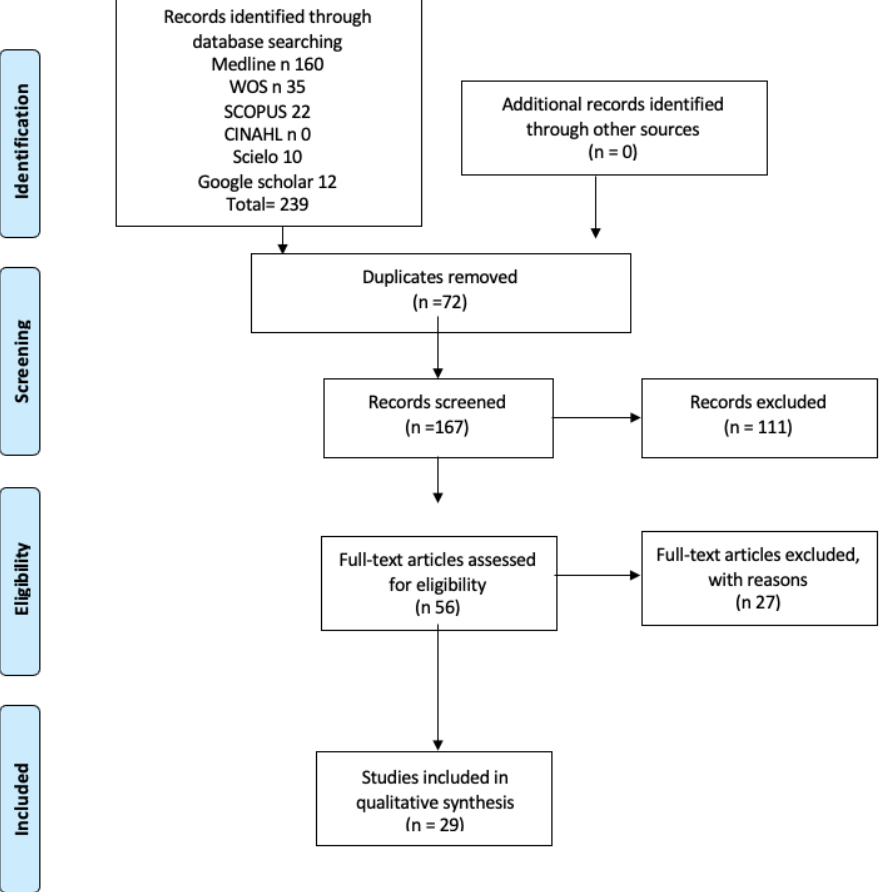
Figure 1. The search flowchart is shown in the